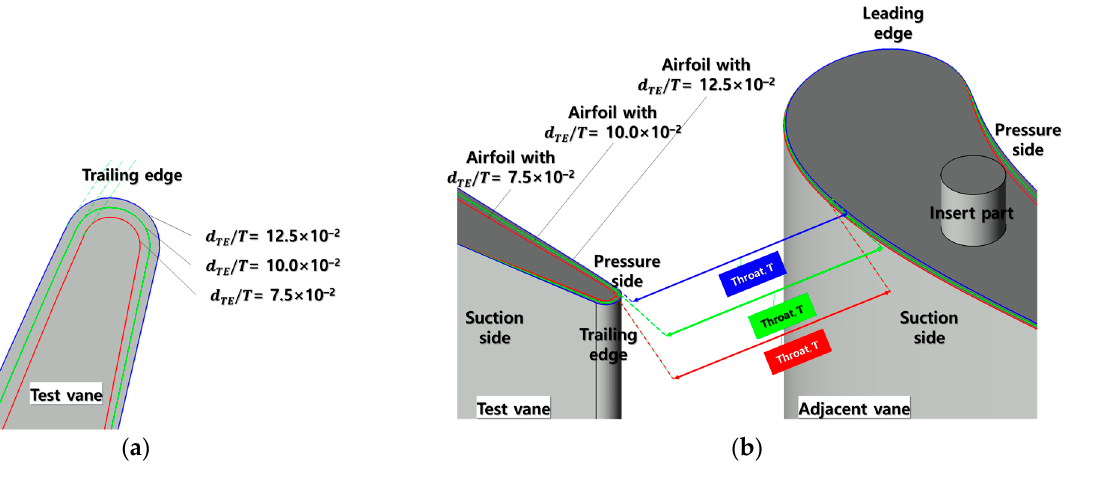
Figure 1. The schematic of the tested vane with different trailing edge diameters: ( a ) airfoil layout showing various trailing edge diameters; ( b ) throat width of vane array.